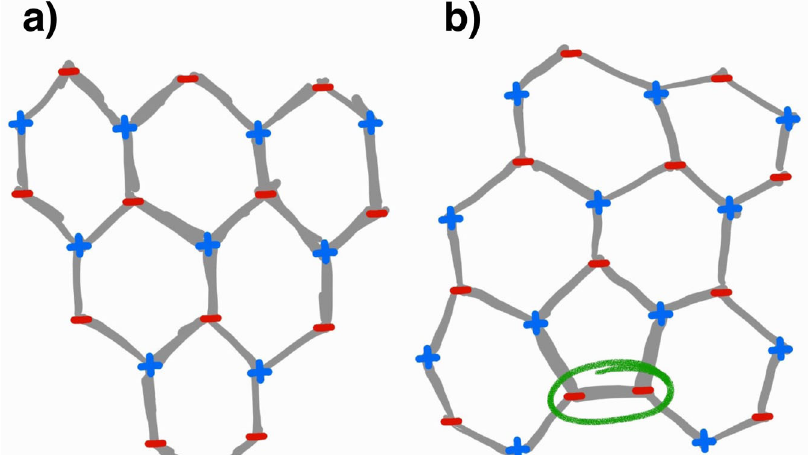
Fig. 4 Pictorial representation of the highest frequency out-of-plane oscillation. a The Highest frequency ZO vibrational mode 49 in graphene. b Construction of a ZO vibrational mode in a hexagonal lattice with a pentagonal defect. In b , we can see that the presence of pentagons will produce an in- phase motion between fi rst neighbors (circled in green), and consequently, the highest frequency ZO vibrational mode for fullerenes will be lower than the one in graphene. The blue plus and red negative signs represent atomic motions going in and out of the plane,